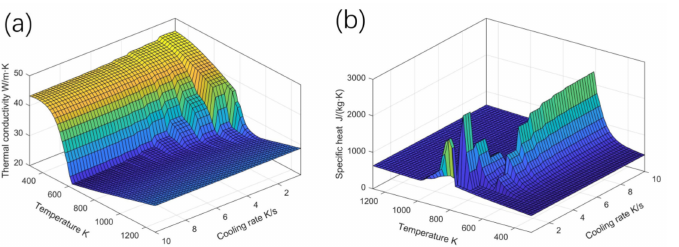
Figure 13. ( a ) Thermal conductivity and cooling rate and temperature; ( b ) specific heat of material and cooling rate and temperature.